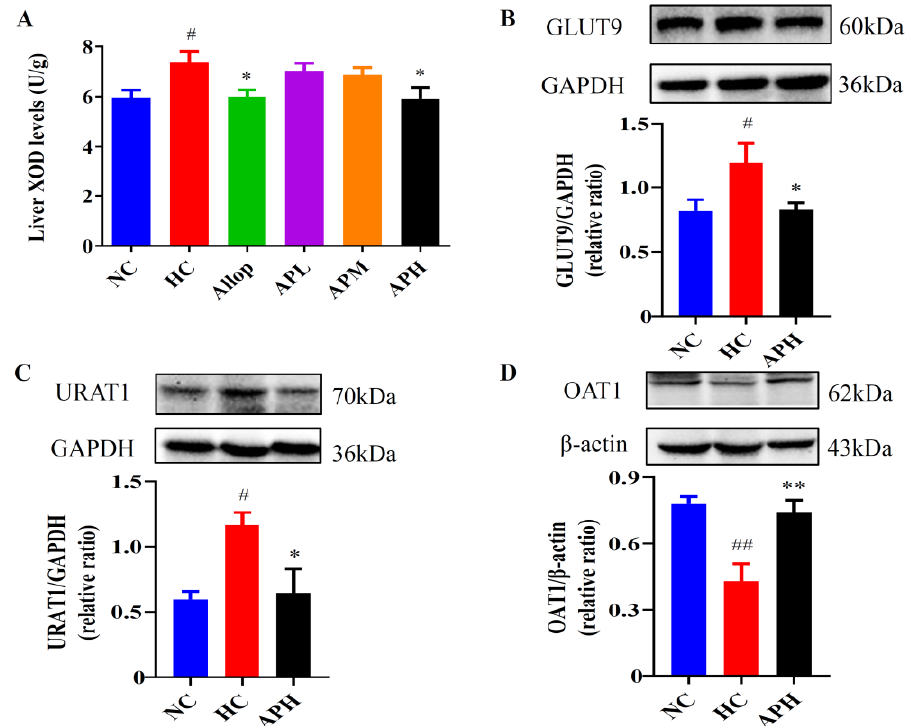
Figure 5. Apigenin decreases liver XOD levels ( A ; U/g, n =10) and renal expression levels of GLUT9 and URAT1, and increases renal expression levels of OAT1 in HUA mice. Representative images of western blot and their analyses show GLUT9 ( B ), URAT1 ( C ), and OAT1 ( D ) expressions in the kidneys ( n ≥ 3). ## p < 0.01, # p < 0.05 vs. the NC group. ** p < 0.01, * p < 0.05 vs. the HC group .